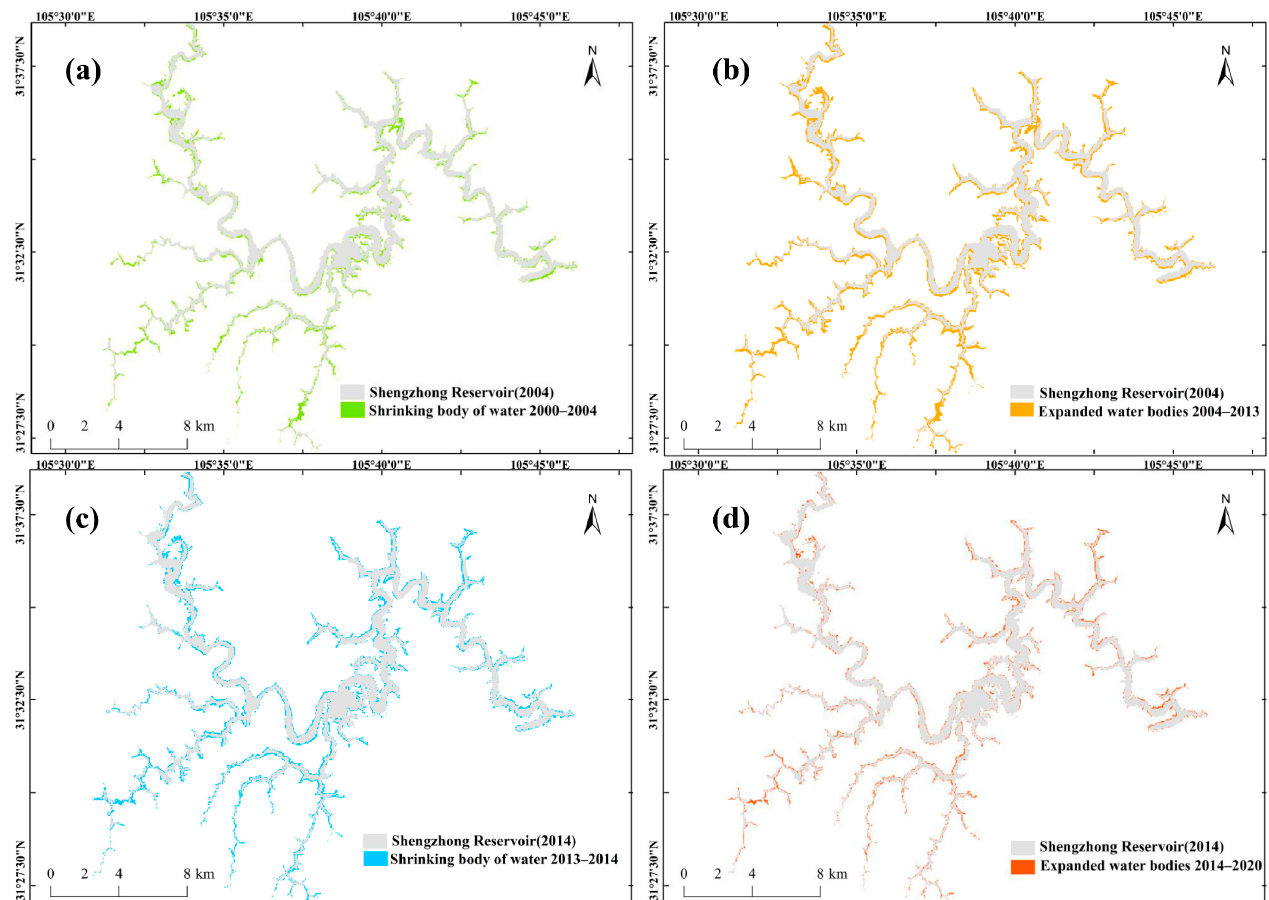
Figure 6. Spatial changes in Lugu Lake. ( a ) The shrinking water bodies of Lugu Lake during 2000–2006; ( b ) After 2006, the Caohai part of Lugu Lake slowly disappeared.